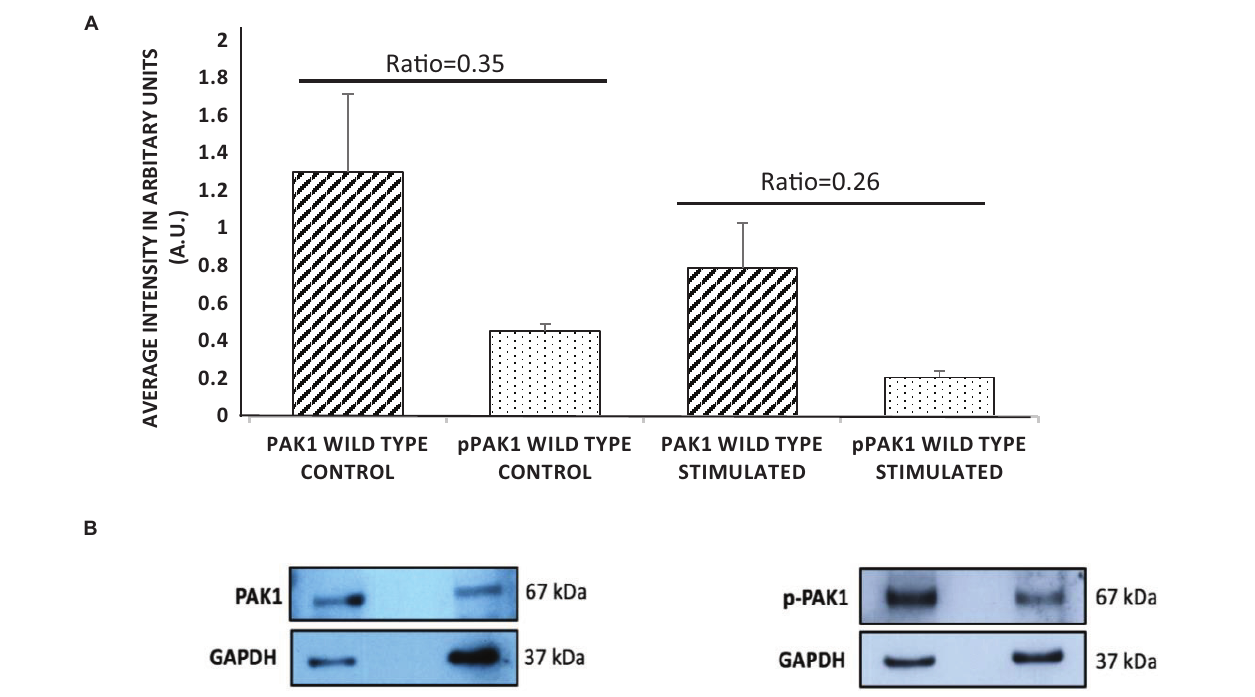
FIGURE 1 | p21-activated kinase 1 expression and phosphorylation decrease with mechanical stimulation. (A) HT1080 cells show significantly decreased total PAK1 levels with stimulation compared to unstimulated cells. In addition, Serine 144 phospho-PAK1 levels significantly decrease with mechanical stimulation, suggesting that PAK1 activity is also decreased with stimulation. (B) Representative western blots of PAK1 and pPAK1 using GAPDH as load controls. The difference in ratio between stimulated and unstimulated cultures was highly significant, P < 0.01 by Student’s t -test. Errors bars show the SEM, n = 3.